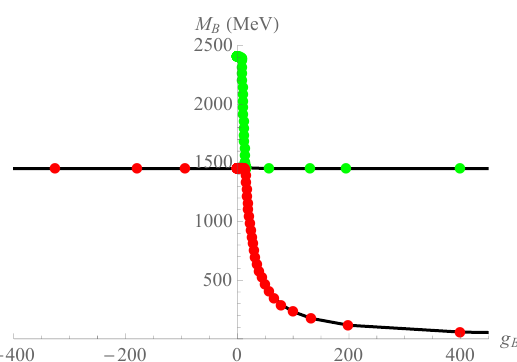
Figure 7. The effect of adding higher-dimensional operators on the mass spectrum of the baryon. The red dots are the results when we drive the ground state lighter and the green ones depict the first